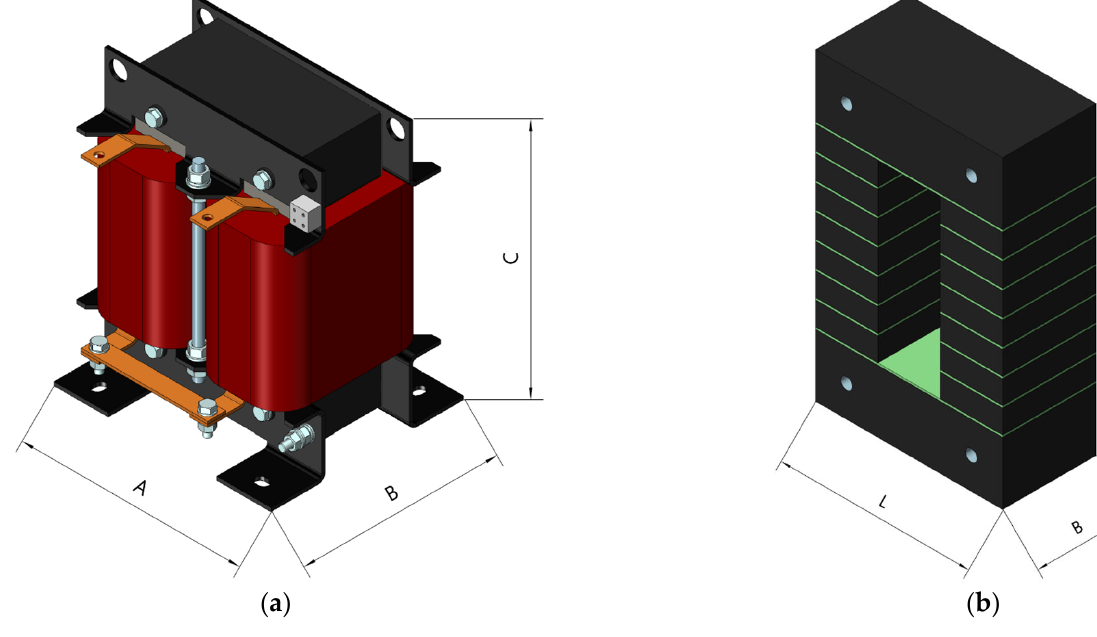
Figure 8. Single phase 2RTF type choke with nanocrystalline block core made with CoreECO multi- gap technology: dimensional draft of the choke ( a ); dimensional draft of the core ( b ). A and L, B, C and H—length, depth and height of the chokes, respectively. Table 3. Choke cores magnetic materials